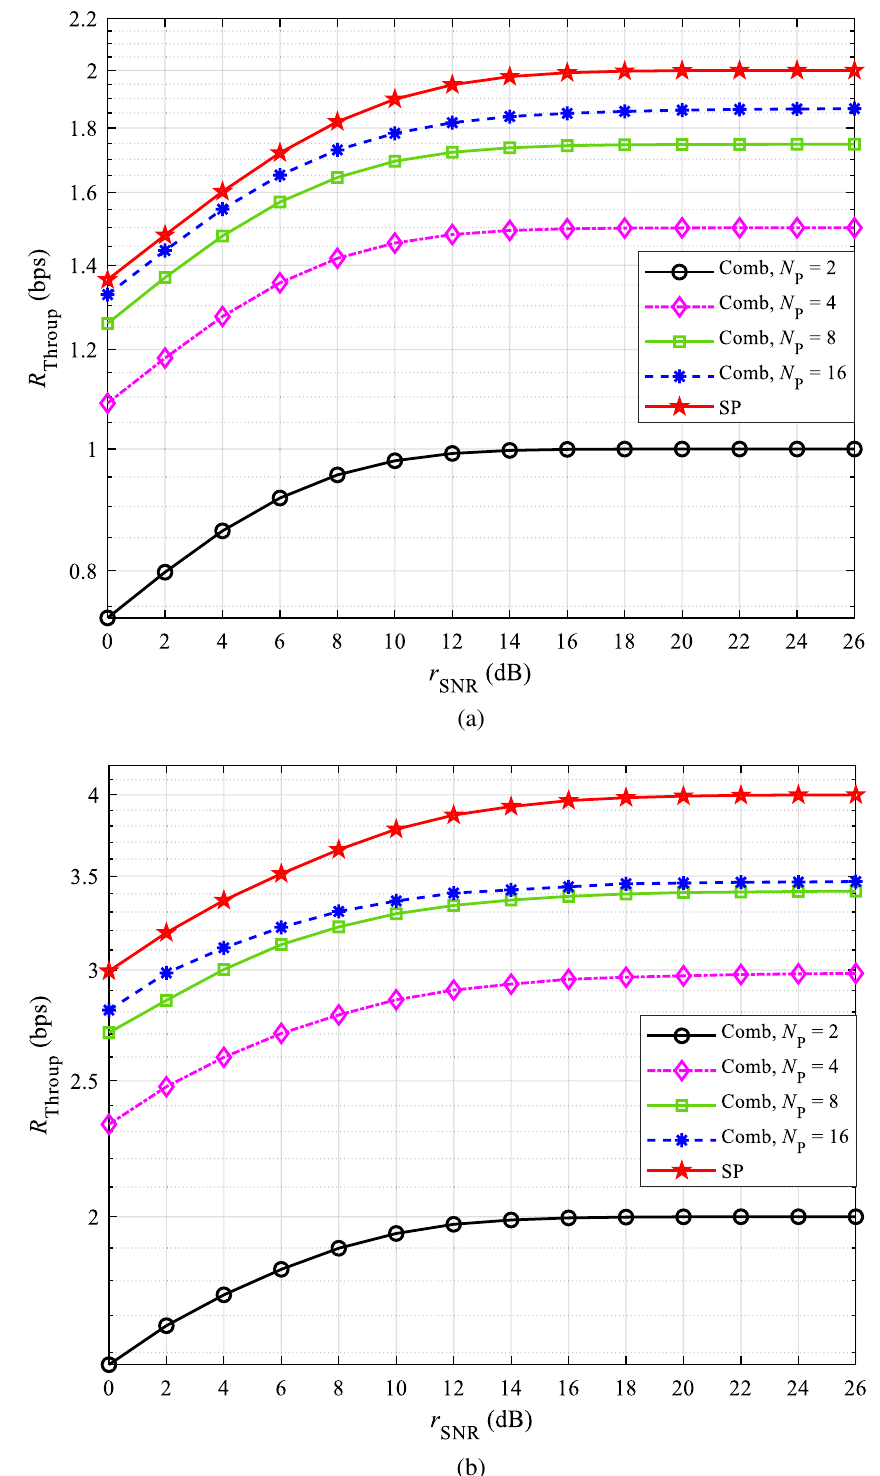
Figure 9. Throughput comparison of SP and comb pilot with different pilot intervals: ( a ) QPSK and ( b )